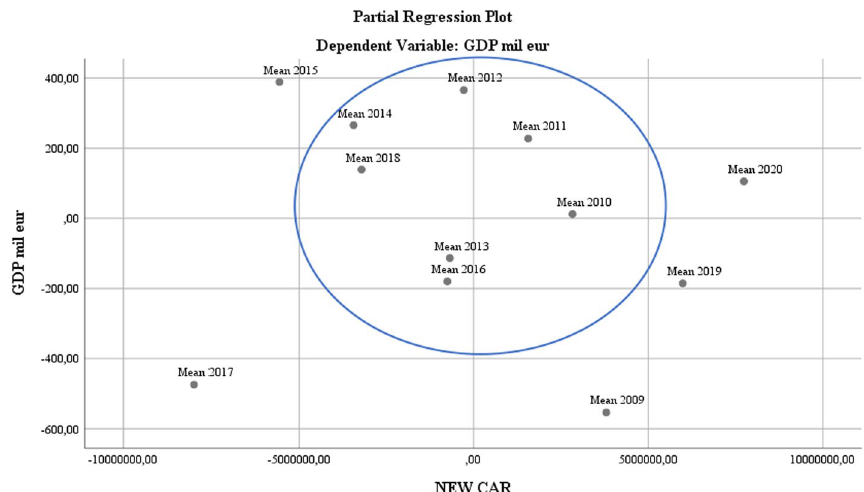
Fig. 10 New car regression analysis. Source : Author`s